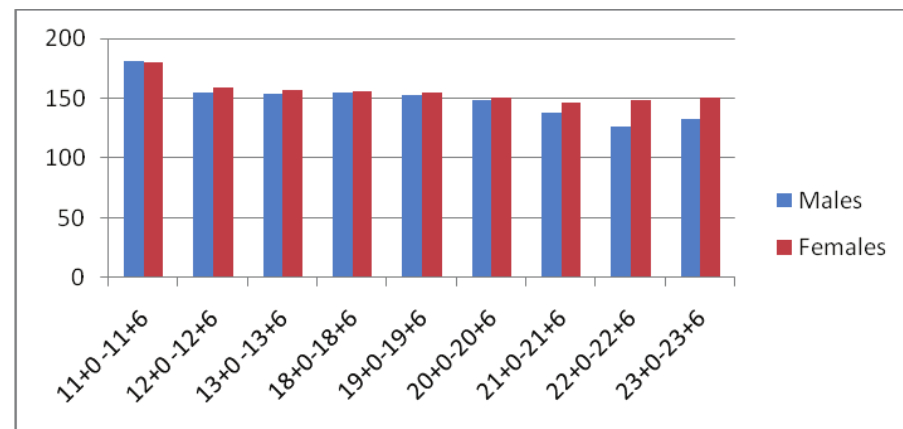
Figure 3 : Trend in fetal heart rates in the first and second trimesters. Note: X axis: Fetal heart rates (bpm); Y axis: Gestational age